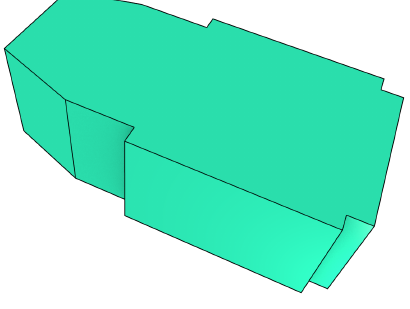
Figure 3: An unchanged building footprint at two LODs forms a prism-shaped